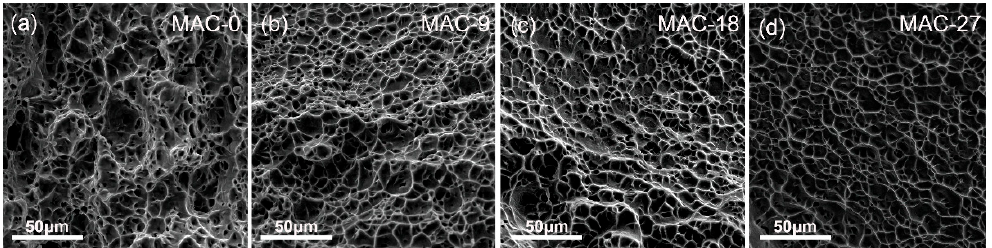
Figure 4. Tensile fracture: ( a ) solid solution MAC-0 sample, ( b ) MAC-9 sample, ( c ) MAC-18 sample, and ( d ) MAC-27 sample.